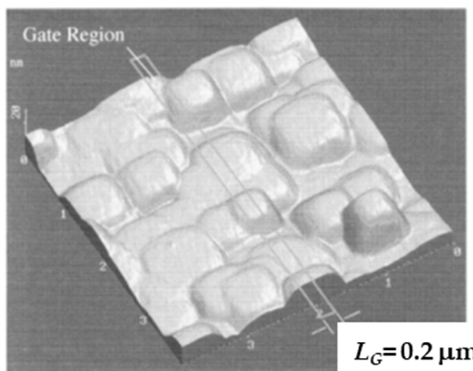
Figure 9. Atomic force microscopy (AFM) image of surface morphology of the bottom surface of the silicon layer. Reproduced with permission from [45], published by IEEE, 1996.